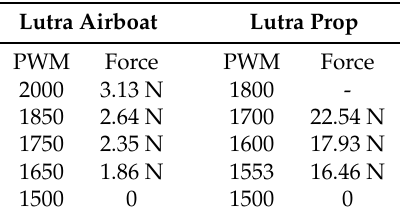
Table 3. Propulsion forces of the boats. PWM stands for Pulse Width